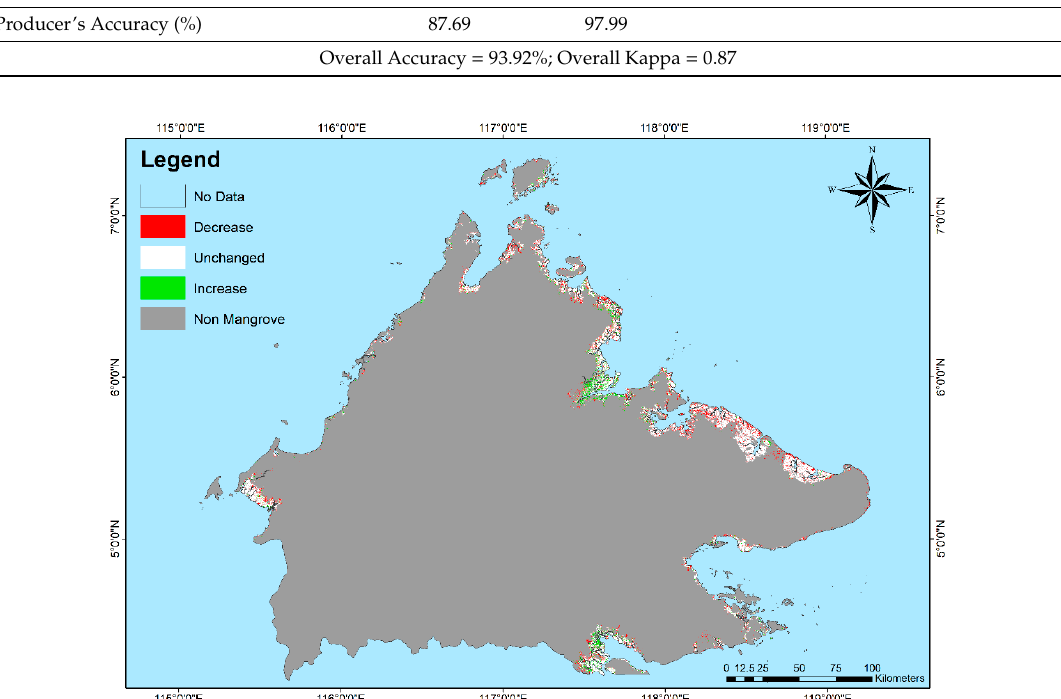
Figure 5. Changes in mangrove forest cover in Sabah between 2000 and 2015. Table 5. Summary of the Observed and Estimated Field Variables Mangrove Forest in the Study